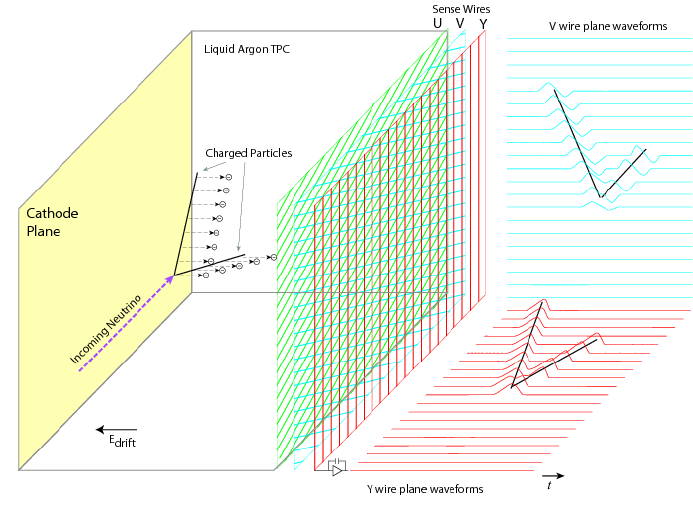
Figure 4. Diagram from [10] illustrating the signal formation in a LArTPC with three wire planes [11]. For simplicity, the signal in the first U induction plane is omitted in the